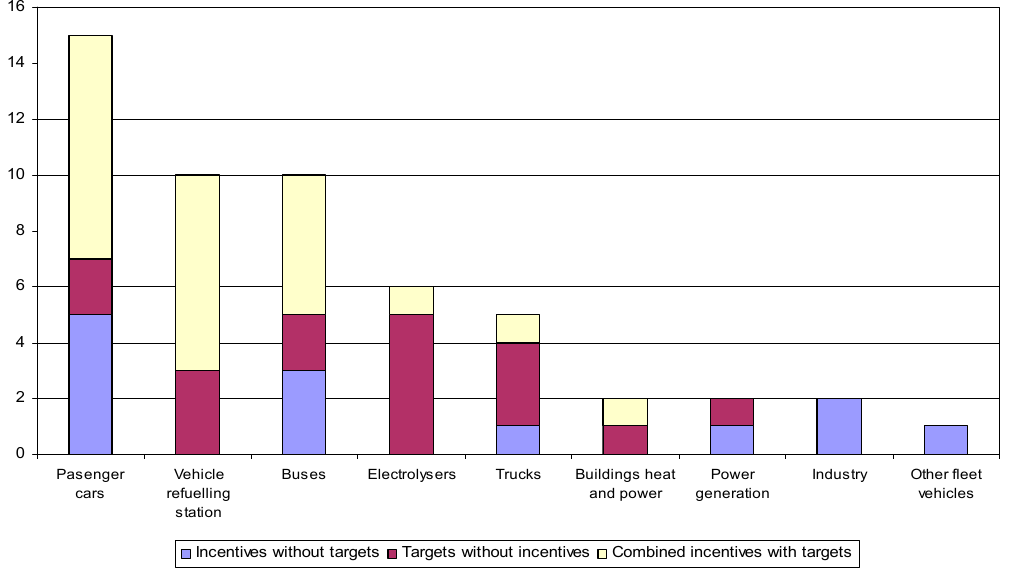
Figure 2. Current policy support for hydrogen deployment, 2018. Source: https://www.iea.org [3]. According to Hydrogen Europe [4], the largest industry organization that unites the largest producers of biohydrogen for the industrial and transport sectors, the key document, Hydrogen in the EU Green Deal COM (2019), includes the most important postulates